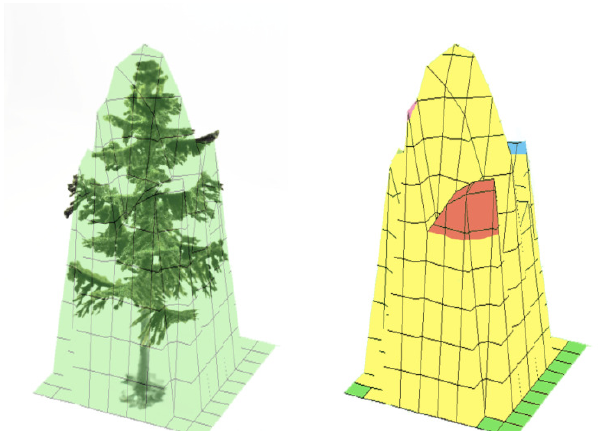
Figure 2. Several possible distributions of the volume Figure 3 shows an example how the nDSM for a sample tree is assigned to the local maxima. A flow simulation that starts with the highest maximum can calculate this distribution. The typical runtime of this algorithm is O(n 2 ), but with an implementation that takes advantage of the limited height of a tree and the denumerable amount of height levels in a tree (typically centimetre levels) it is possible to accelerate this algorithm to O(n). This more advanced implementation belongs to the class of plane sweep algorithms.